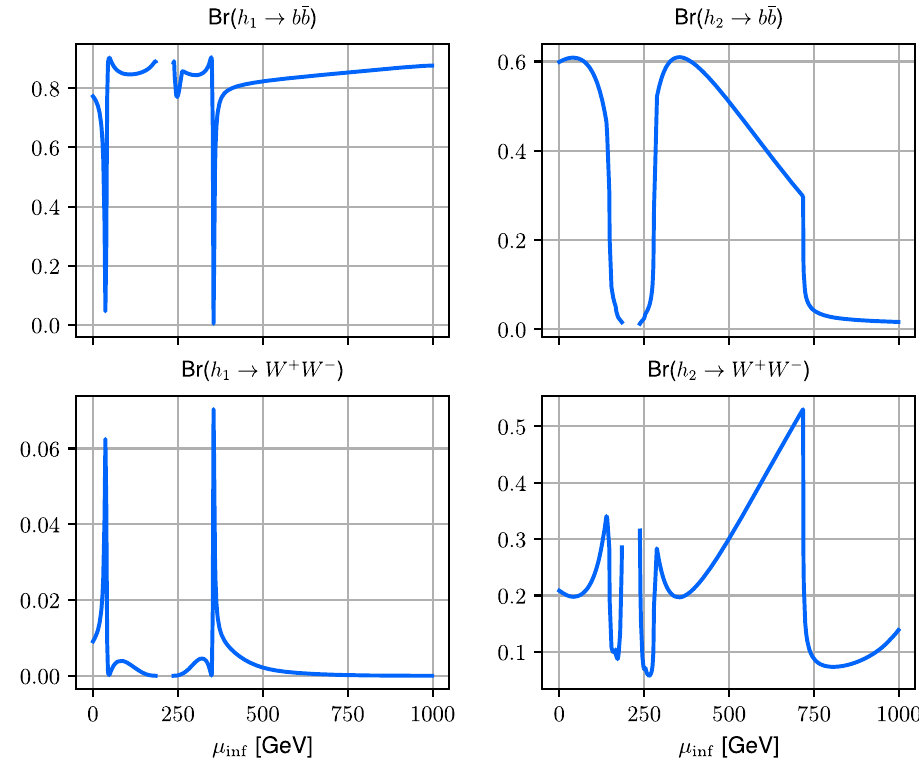
Fig. 5 The branching ratios of h 1 and h 2 decay to b quarks or W bosons depending on μ